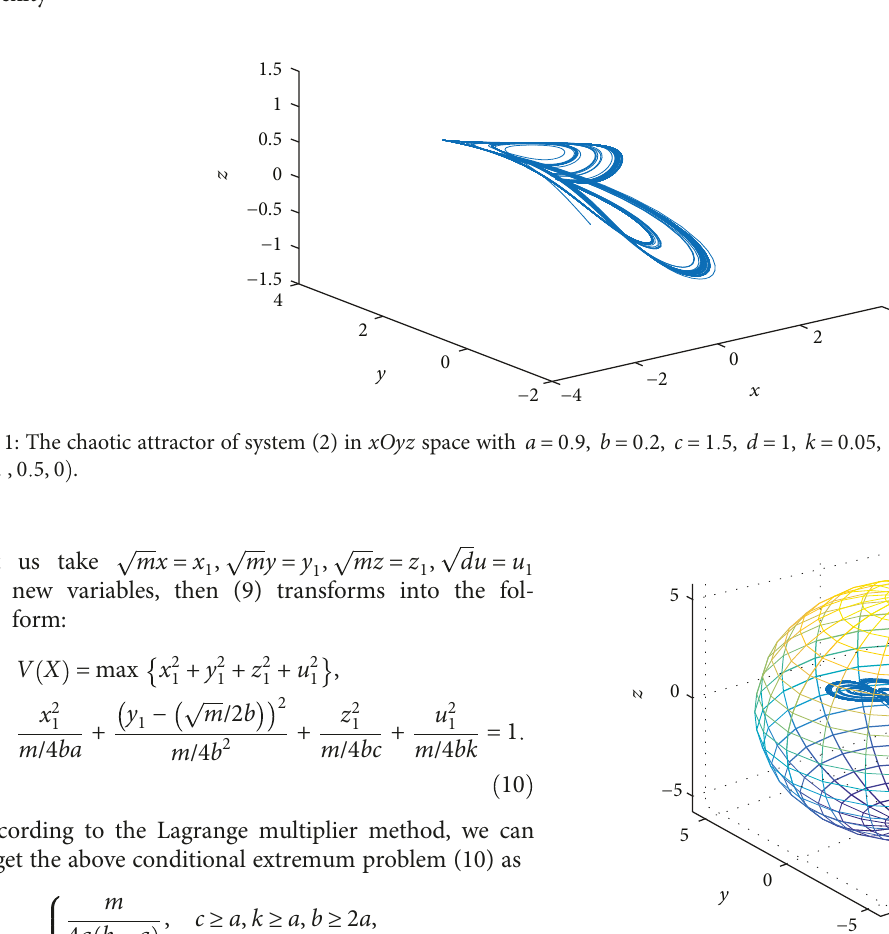
Figure 2: The chaotic attractor of system (2) in the xOyz space with a = 0 9, b = 0 2, c = 1 5, d = 1, k = 0 05 , and de fi ned by Ω 1 m = 0 005